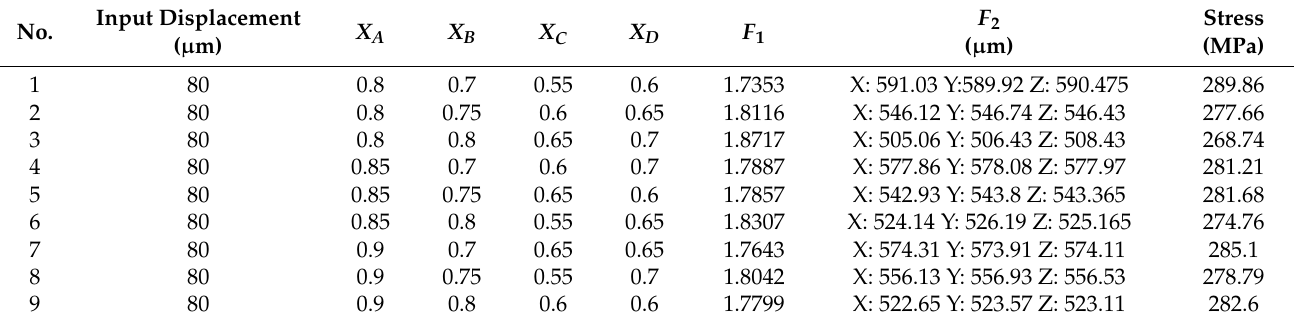
Table 5. Numerical results (Input displacement of 80 µ